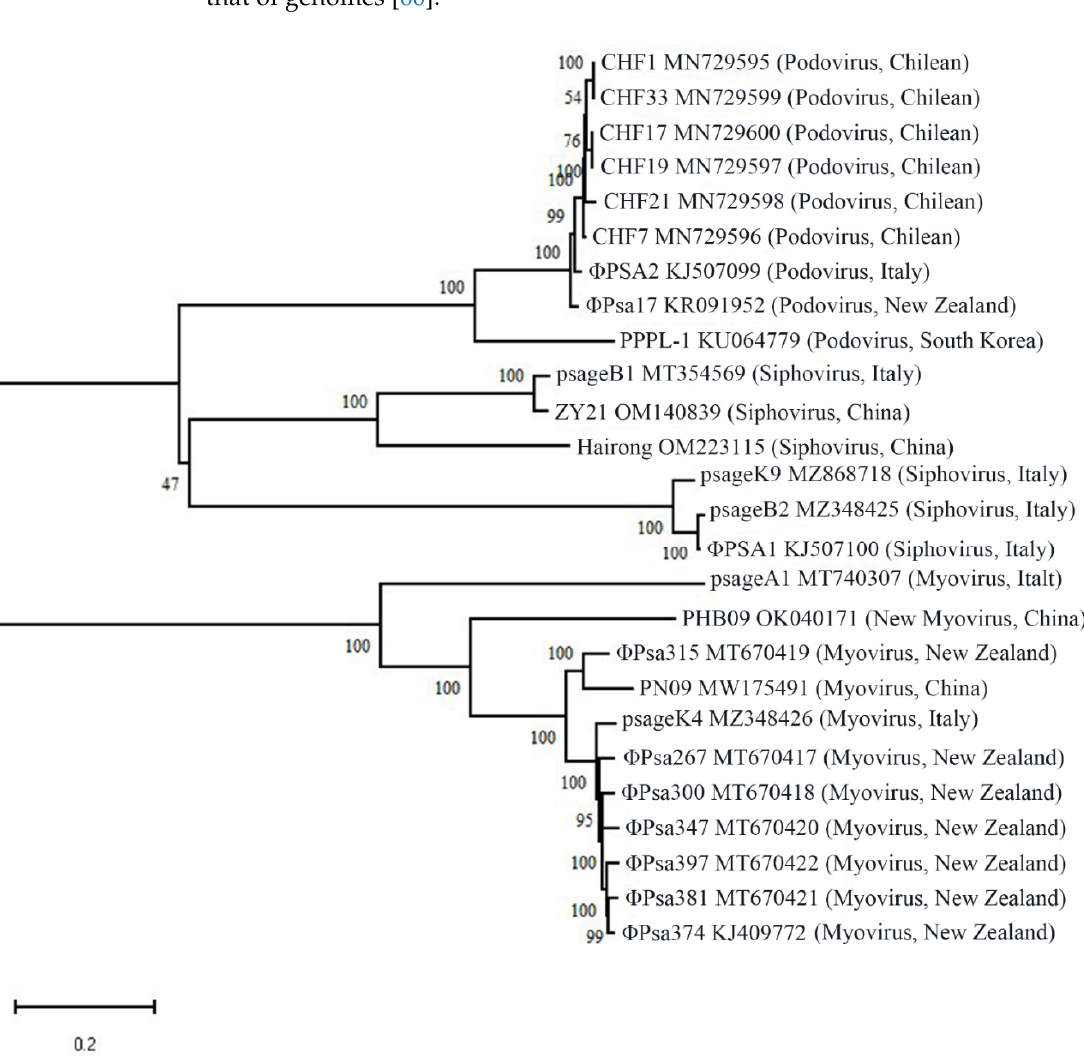
Figure 1. Phylogenetic tree of the Psa phages was constructed by MEGA 7.0 software using the maximum composite likelihood method based on the genome sequences available in the NCBI database. Nodes show the result of 1000 bootstrap replicates. The genome sequences were aligned using the MAFFT multiple sequence alignment (http://mafft.cbrc.jp/alignment/software/; accessed on 27 November 2022).